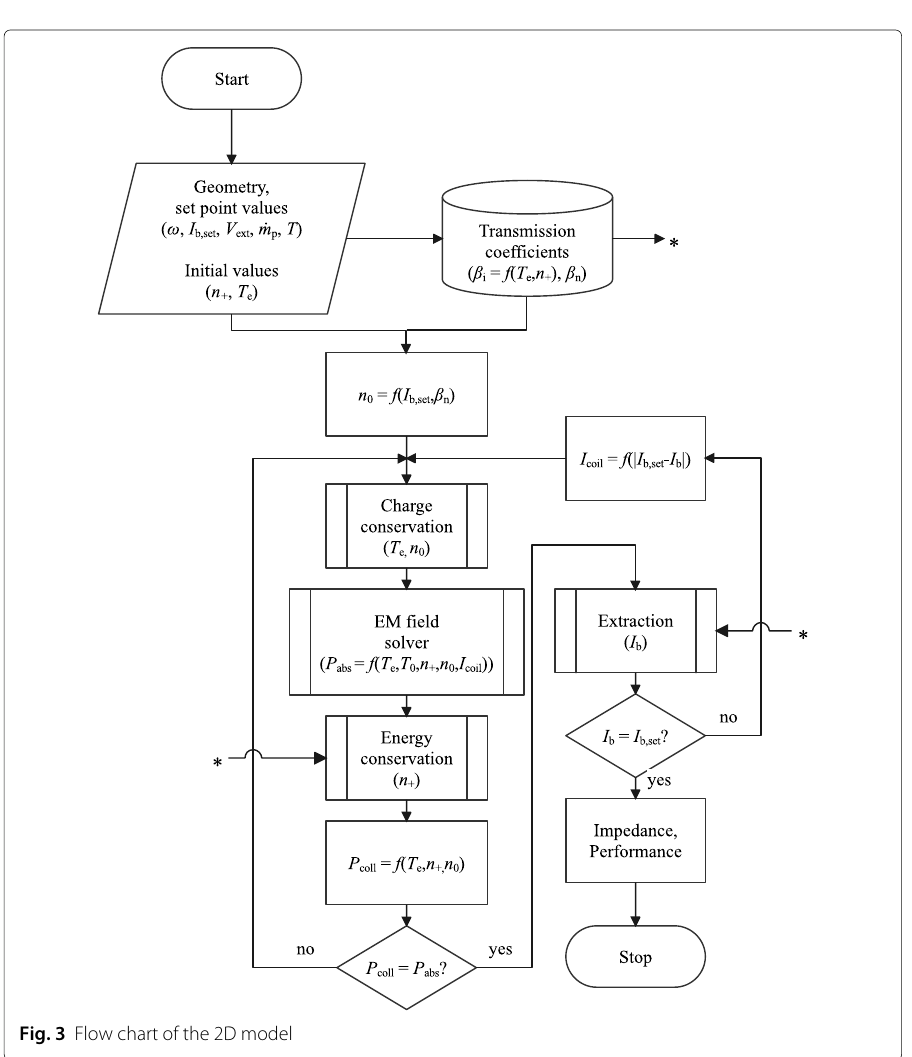
Fig. 3 Flow chart of the 2D